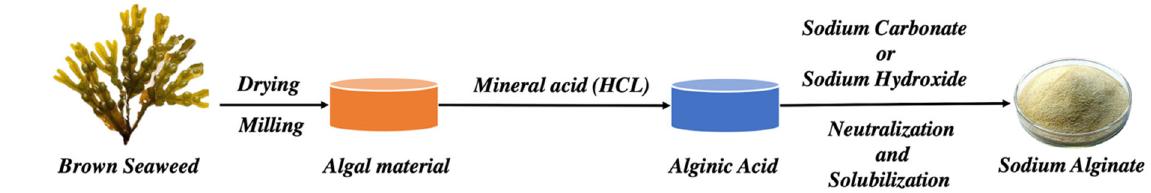
Figure 3. The extraction technique of ALG from brown seaweeds.